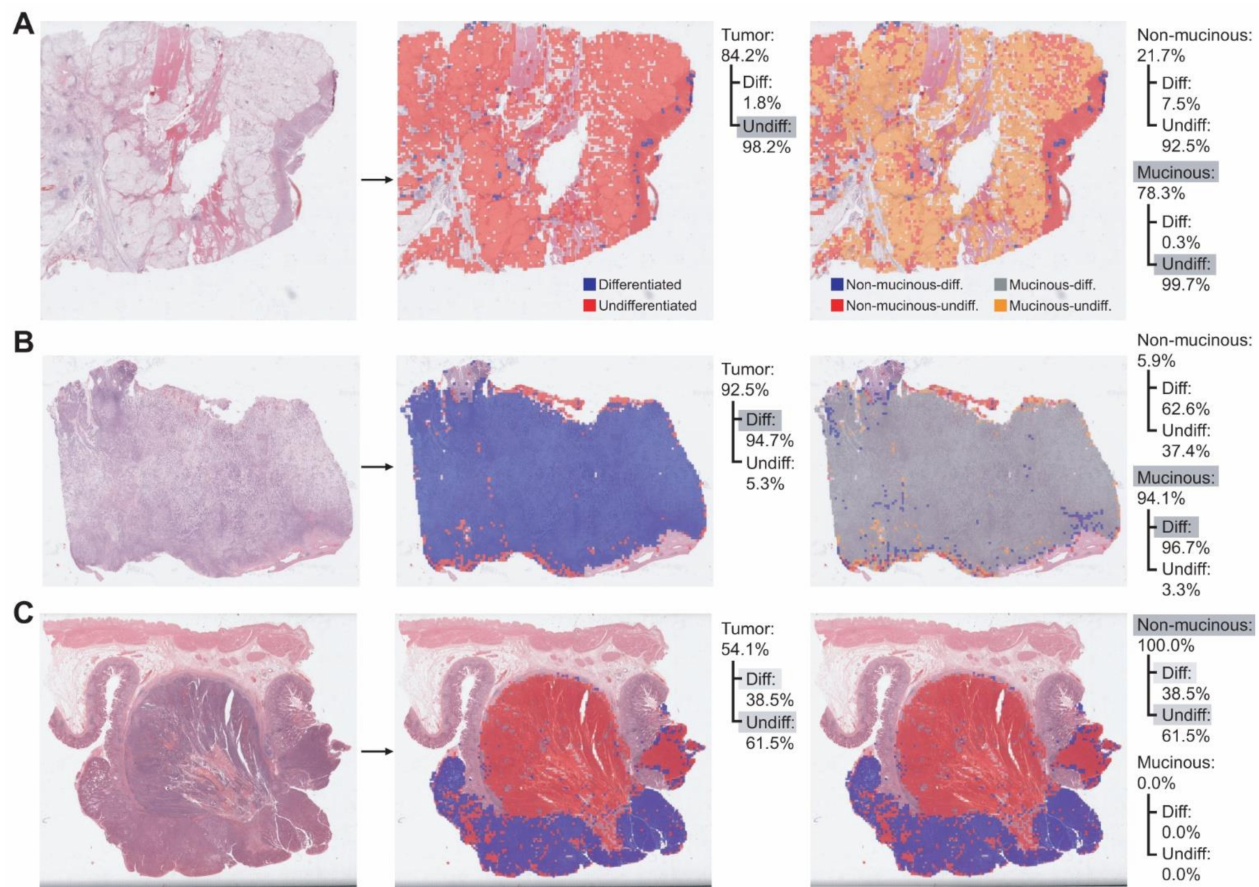
Figure 4. Quantitative evaluation of the subclasses in gastric cancer tissues. ( A ) A representative cancer tissue consisting of mainly undifferentiated and mucinous tissues. ( B ) A representative cancer tissue consisting of mainly differentiated and mucinous tissues. ( C ) A representative cancer tissue consisting of mixed differentiated, undifferentiated and non-mucinous tissues. The relative proportion of each subclass was calculated. Grey shades indicate the major